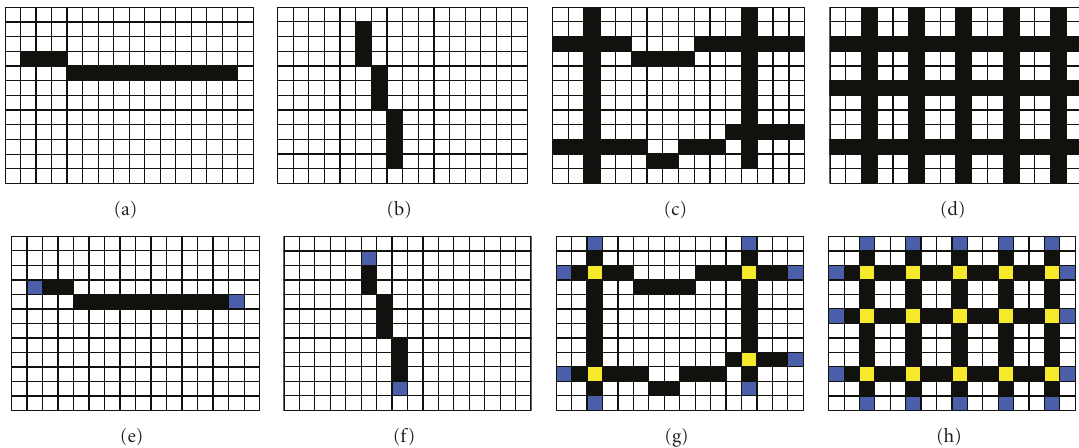
Figure 4: Examples for singularity point detection. Images (a–d) are computer simulated crack skeleton maps for the transverse crack, the longitudinal crack, the block crack, and the alligator crack, respectively. Images (e–h) are the corresponding results for singularity point detection, where the black points refer to the crack points, the blue ones denote the endpoints, and the yellow ones represent the junction points.